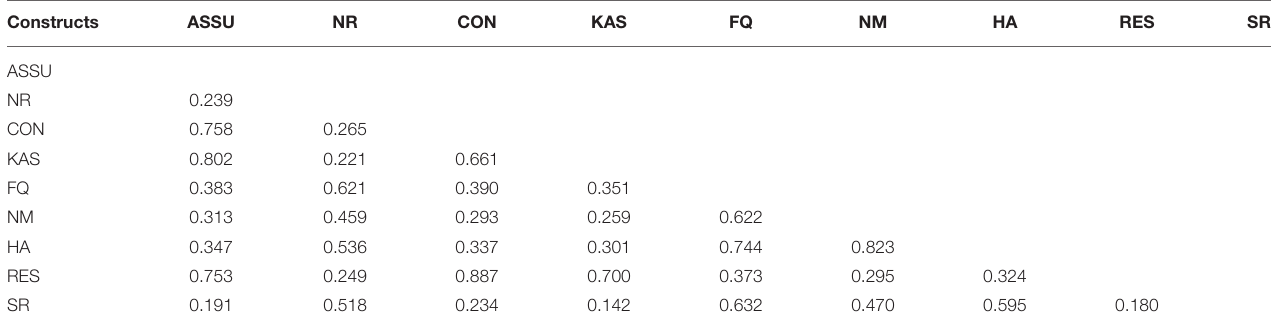
TABLE 2 | Discriminant validity: HTMT. Constructs